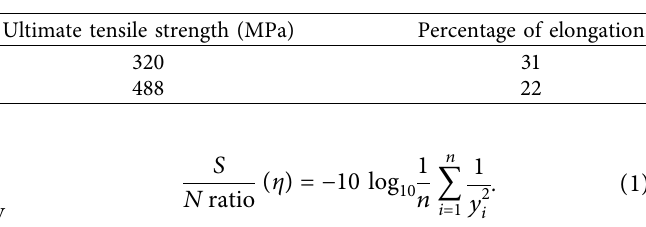
Figure 2: Welded Table 3: Materials’ mechanical characteristics.